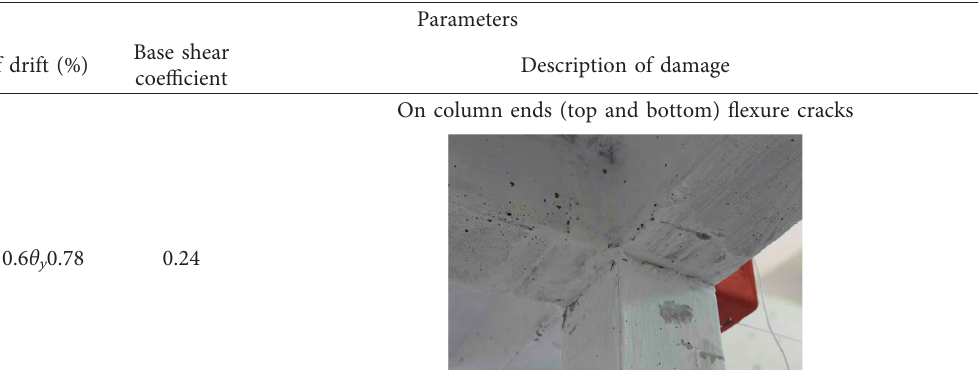
Figure 10: Development of base shear coefficient (BSC) and roof drift for averaging and respective damage limits. Table 4: Considered frame typology damage-specified performance level